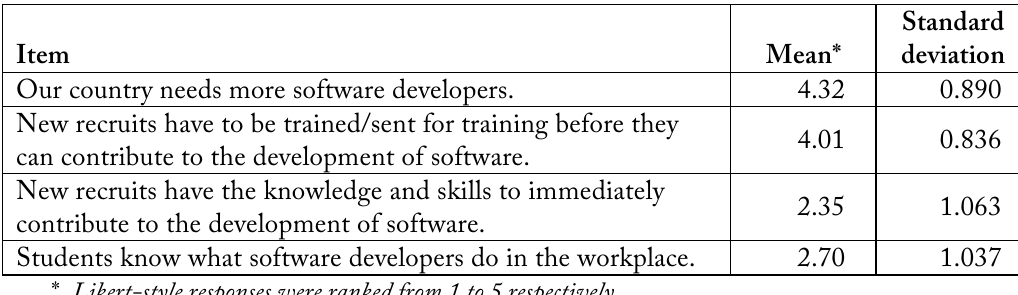
Table 5: Basic analysis of gap